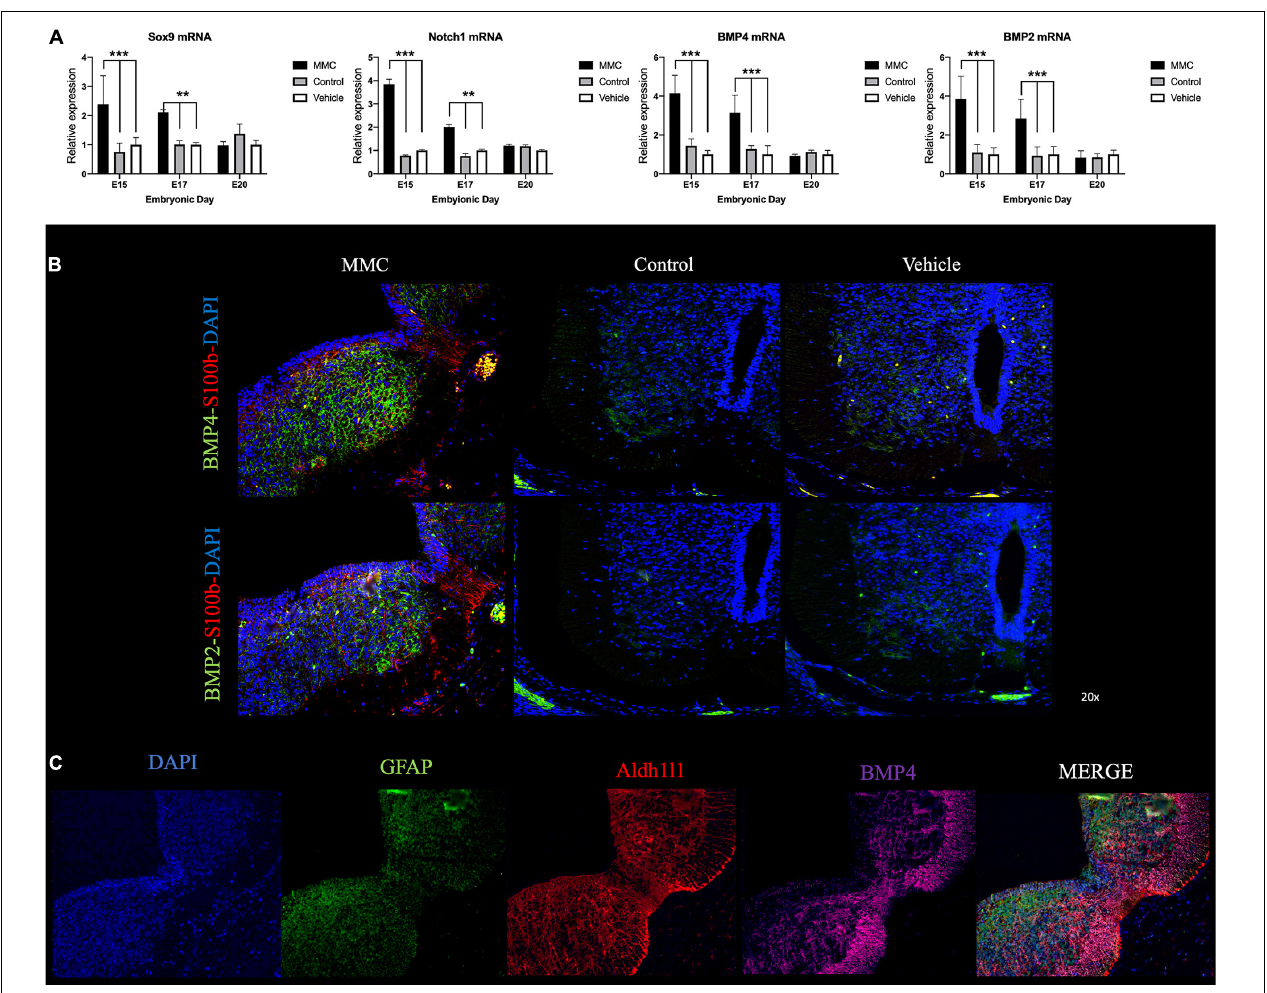
FIGURE 10 | Notch-BMP signaling activation in spina bifida. (A) Relative expression of Sox9, Notch1, BMP2, and BMP4 in MMC, control, and vehicle fetuses at E15, E17, and E20. Means ± SE ( n = 6 fetuses/group) of relative expression (2 – (cid:49)(cid:49) Ct ) for RA-treated and time-matched controls; (** p < 0.01, *** p < 0.001). (B) Co-staining of BMP-2 (green), BMP-4 (green), S100b (red), and DAPI (blue) in spinal cords collected from MMC, control, and vehicle fetuses at E17 (20 × images). (C) Co-staining of BMP-4 (magenta), Aldh1l1 (red), GFAP (green), and DAPI (blue) in spinal cords collected from MMC at E17 (20 ×